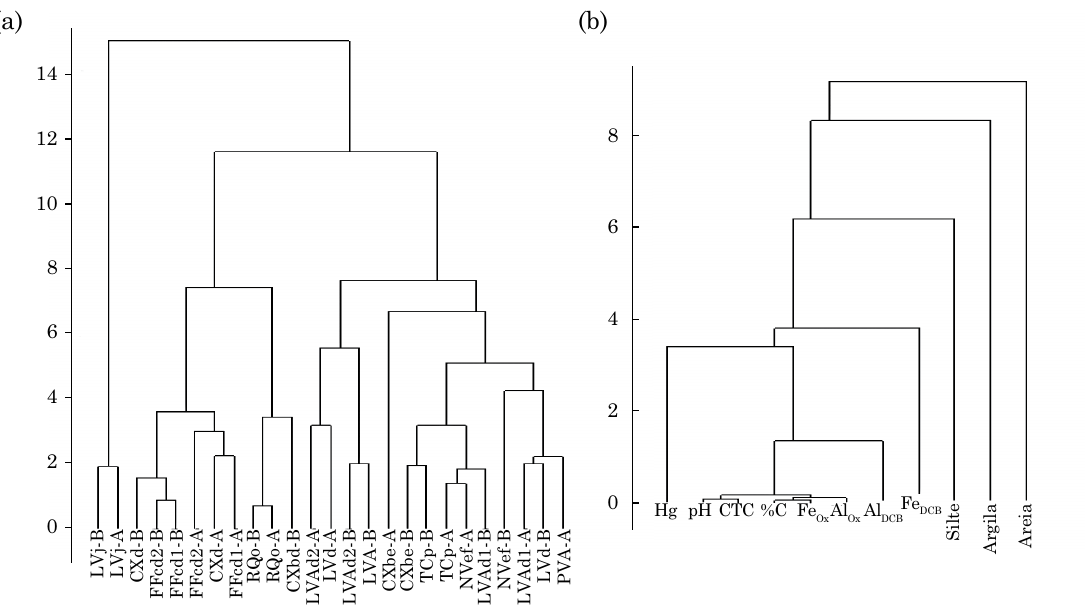
figura 5. dendogramas das (a) amostras e (b) variáveis obtidos por Hca para os dados escalados, empregando-se o método de Ward e distância de